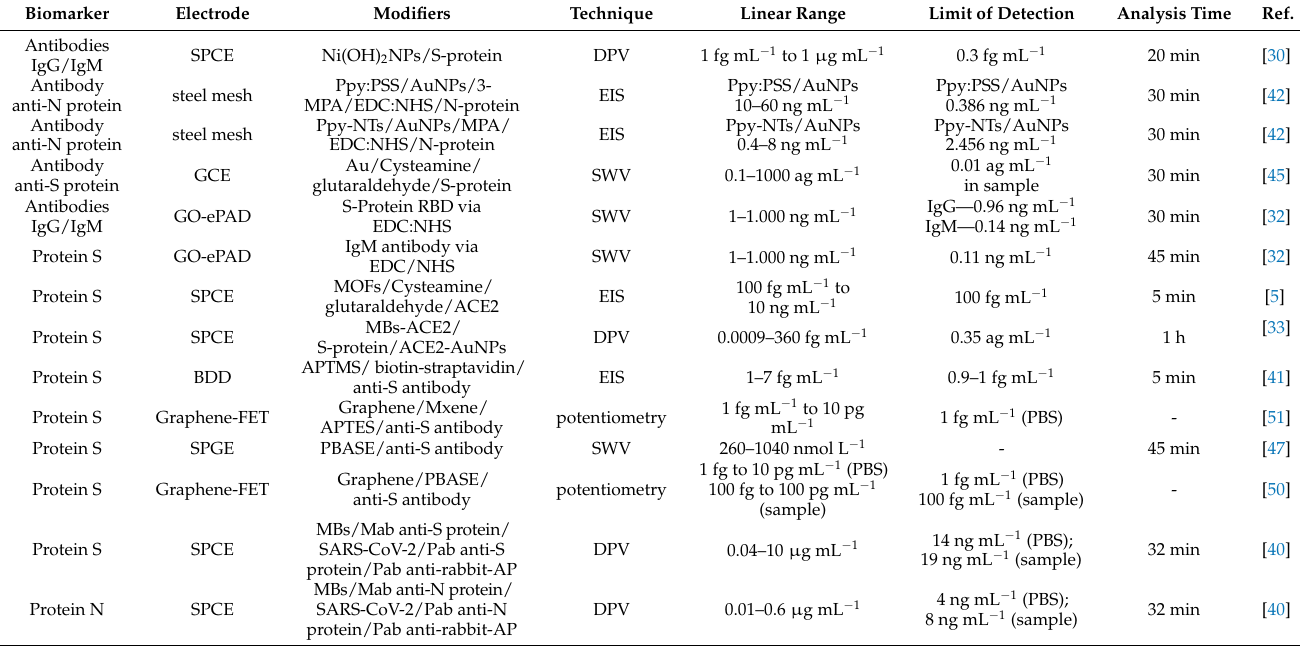
Figure 6. Circuit illustration of the Mxene–graphene FET sensor, antibody-antigen detection mech- anism, and the signal obtained from a change in source current (adapted from [51]). Table 2 summarizes the electrochemical immunosensors for detecting SARS-CoV-2 mentioned in this review. Table 2. Summary of most methods developed for the detection of SARS-CoV-2 based on electro- chemical immunosensors.